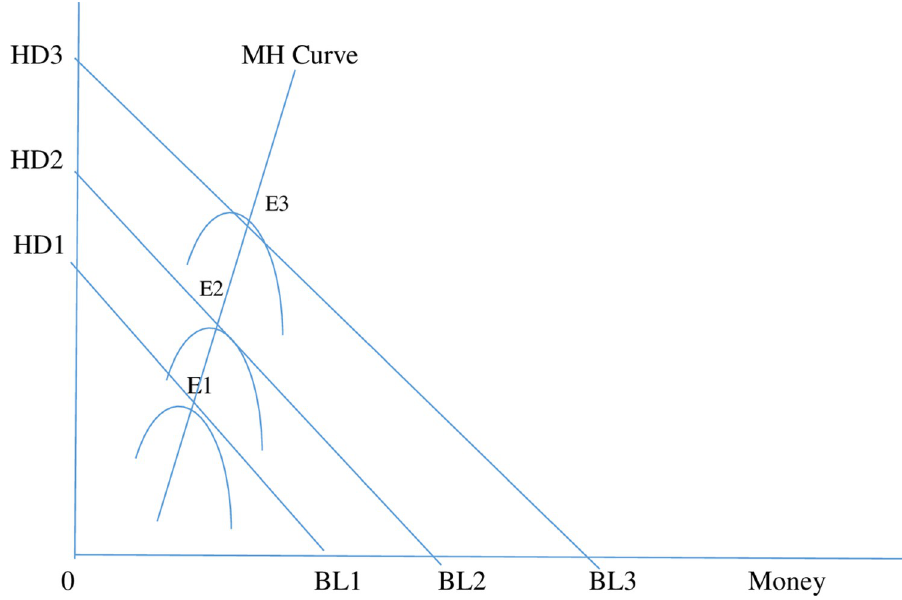
Fig 1. Money-and-health (MH) curve. Source: Author’s